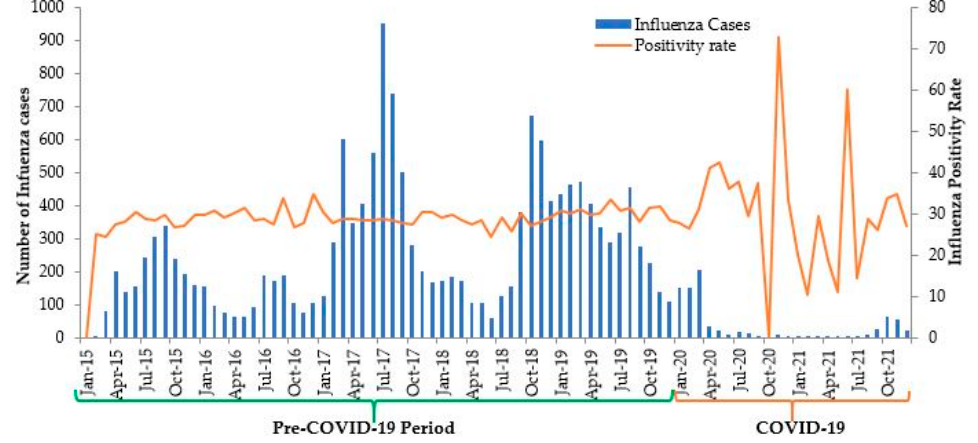
Figure 2. Line diagram depicting the number of influenza cases detected month ‐ wise and test posi ‐